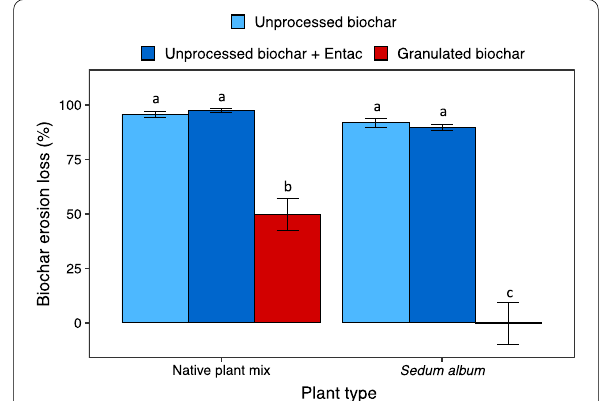
Fig. 1 Biochar erosion loss on green roof modules. Mean biochar erosion loss in each treatment is plotted replicates per treatment). Bars with different lowercase letters differ significantly at P < 0.05 according to Tukey’s HSD test following two-way